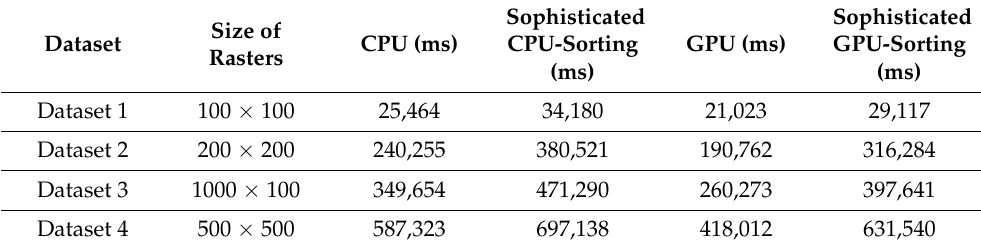
Table 4. Experiments on